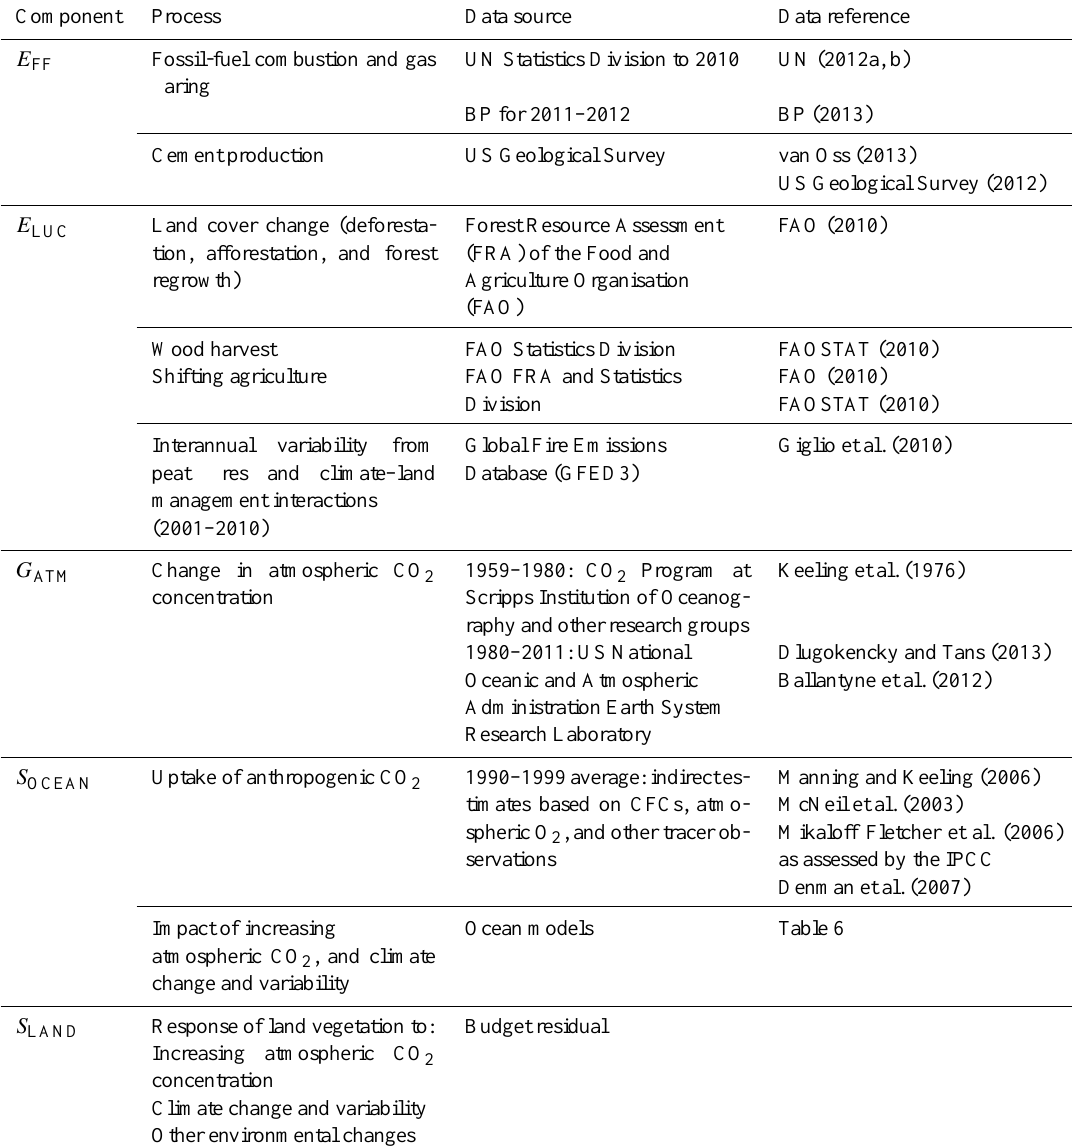
Table 4. Data sources used to compute each component of the global carbon